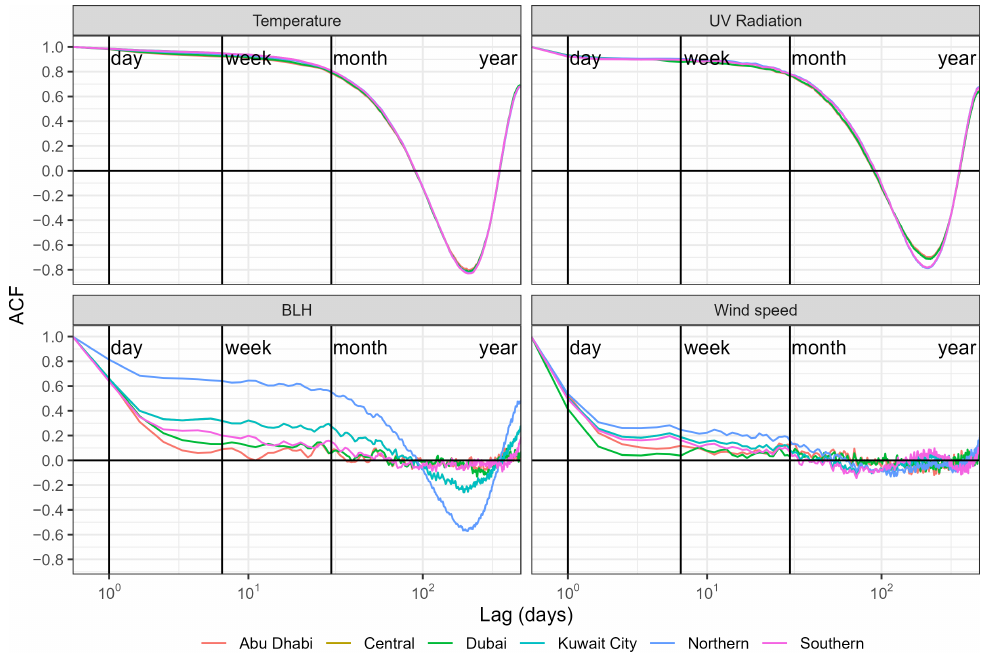
Figure A2. Autocorrelation functions for ERA5 meteorological variables with high importance in the random forests models. The Kuwait City and Central monitors shared the same MERRA-2 pixel and, thus, the same